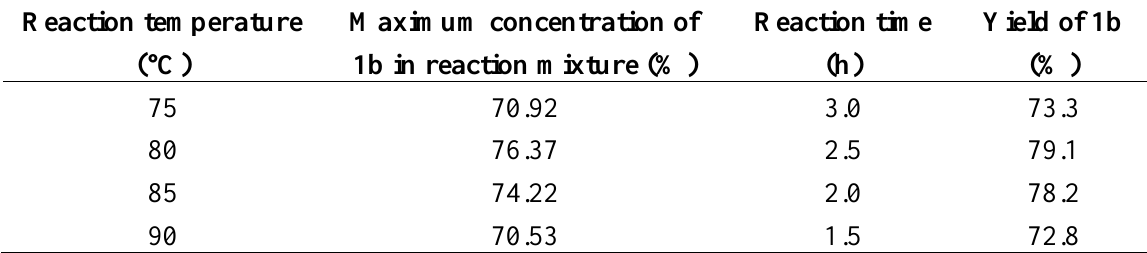
Table 2. Effect of reaction temperature and reaction time on the yield.